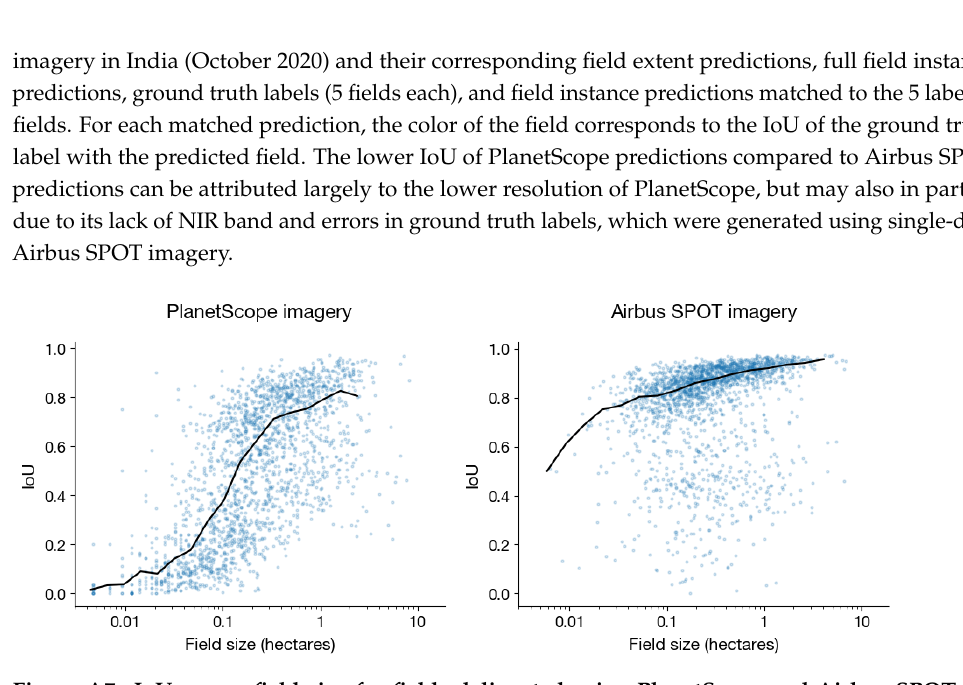
Figure A7. IoU versus field size for fields delineated using PlanetScope and Airbus SPOT im- agery. Results are shown for the best model that employs each type of imagery. The black line shows the median IoU at a given field